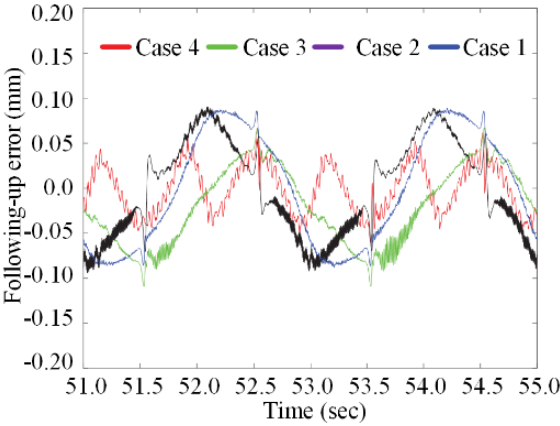
Figure 13. Following ‐ up errors within 4.0s.